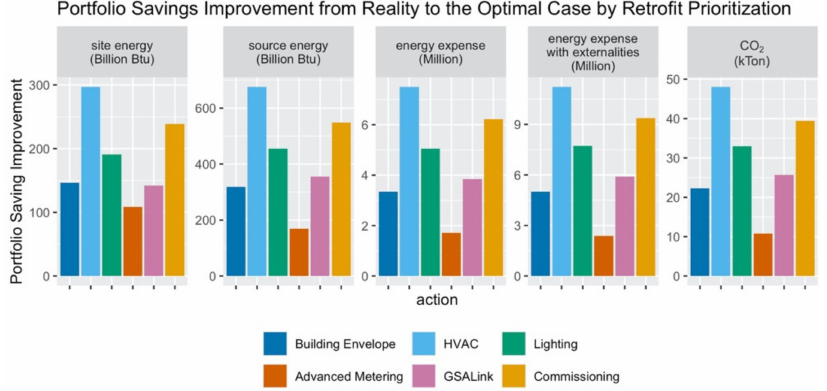
Figure 12. The improvement of portfolio-wide savings from the “reality” case to the “optimal” case